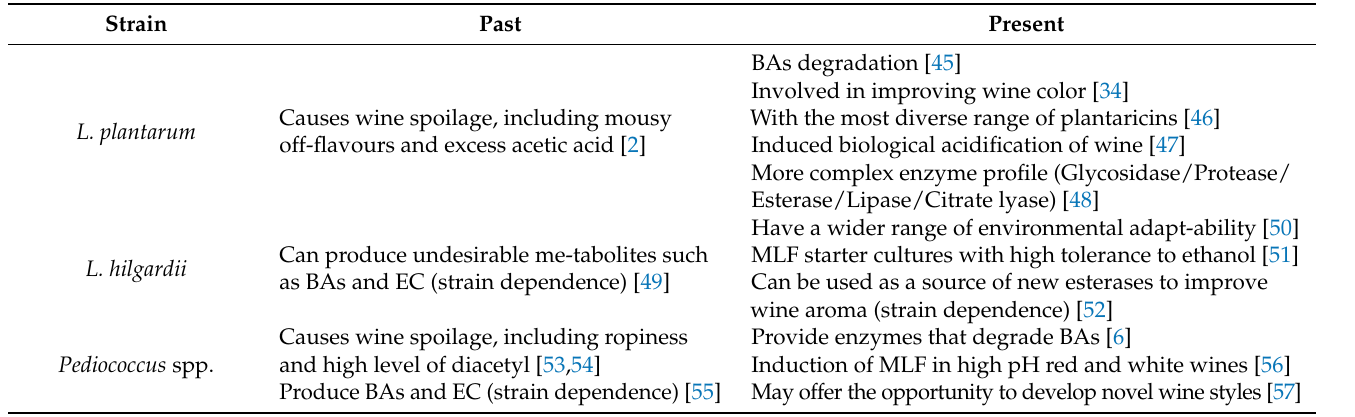
Table 2. New malolactic bacteria and their role in